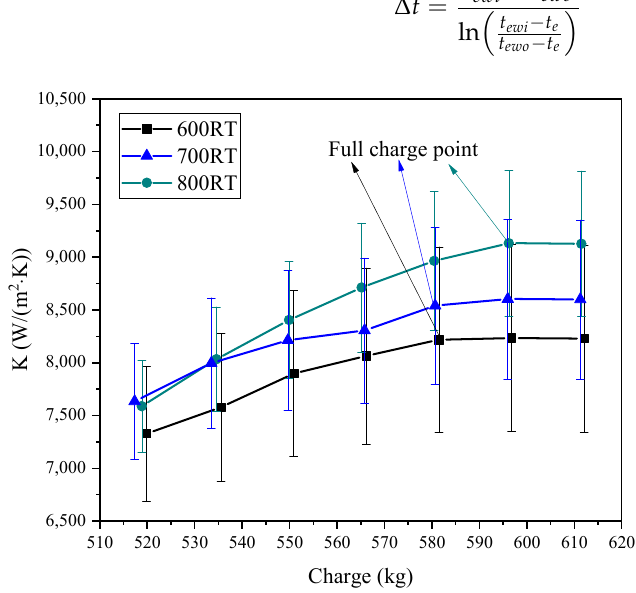
Figure 6. Evaporator total HTC as a function of charge at each cooling capacity.